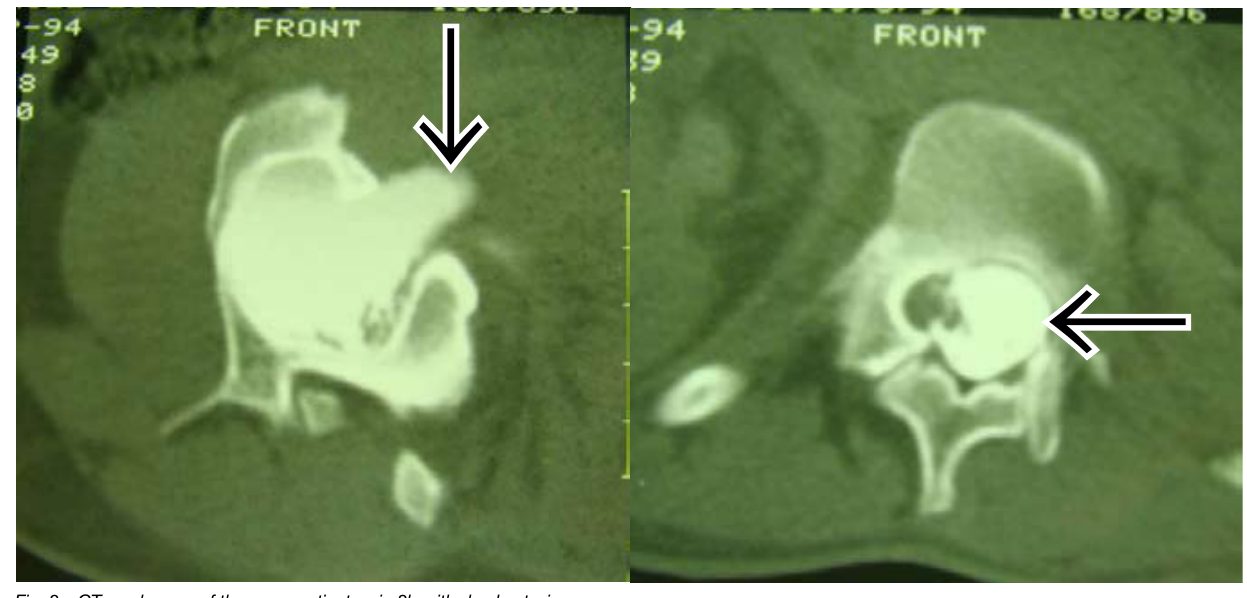
Fig. 8c. CT myelogram of the same patient as in 8b with dural ectasia.